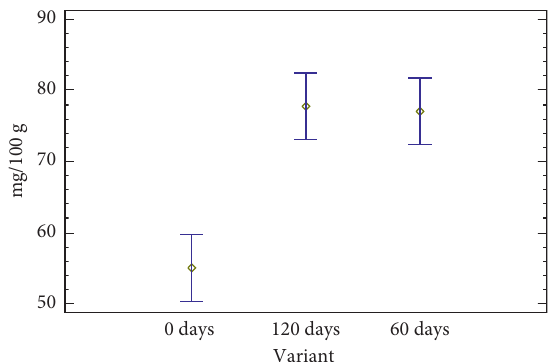
Figure 1: Changes in the total carotenoid content of dry matter of all varieties of Cucurbita moschata Duch. during storage (average of 2018 and 2019).